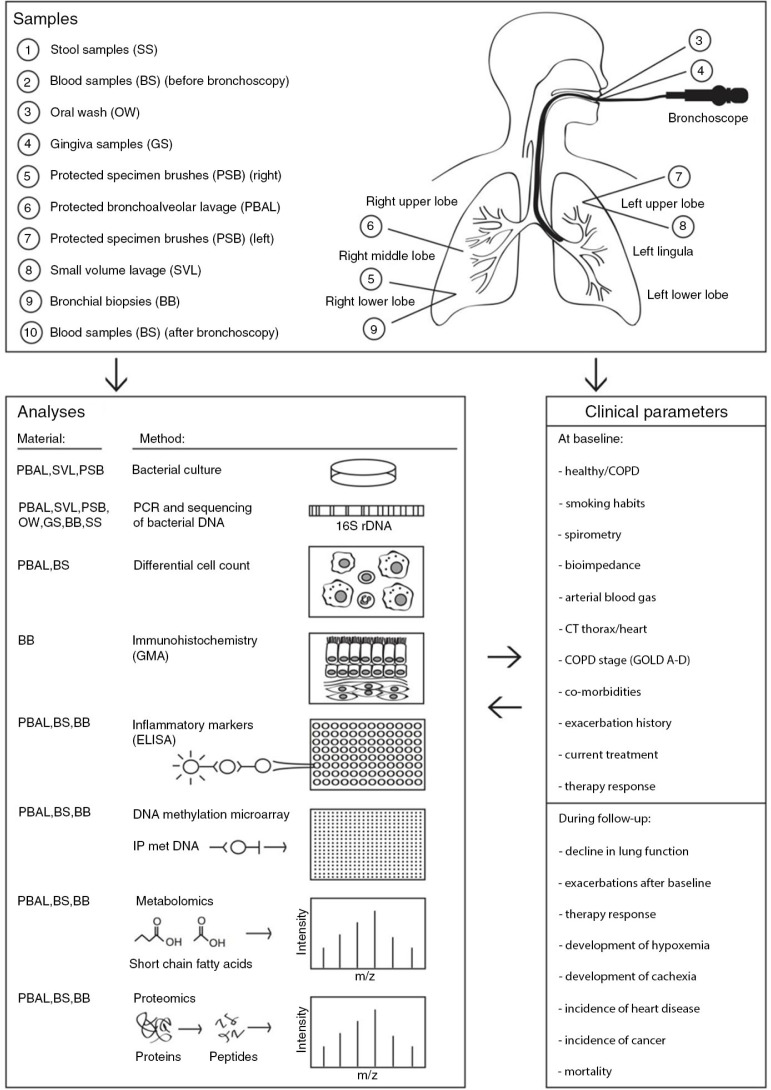
Overview of biological samples, analyses, and clinical parameters obtained from subjects included in the Bergen COPD microbiota study. Biological samples collected before, during, and after bronchoscopies, with order and location of sampling, are indicated in the figure. Stool samples (SS), blood samples (BS), oral wash (OW), and gingiva samples (GS) are collected before the bronchoscopy procedure. During the bronchoscopy, sampling is performed in the following order: three protected specimen brushes (PSB) from the right lower lobe (RLL), protected bronchoalveolar lavage (PBAL) from the right middle lobe (RML), three PSBs from the left upper lobe (LUL), small-volume lavage (SVL) from the LUL, and 4–6 bronchial biopsies (BB) from the RLL. Blood samples are also collected 1 h after the bronchoscopy procedure. The biological samples are analyzed by different methodologies; types of material used for the different analyses are indicated in the figure. Analyses include bacterial culture, PCR and sequencing of bacterial DNA (16S rDNA), differential cell count, glycol methyl acrylate (GMA) immunohistochemistry, analysis of inflammatory markers by ELISA (enzyme-linked immunosorbent assay), immunoprecipitation (IP) of methylated DNA followed by DNA methylation microarray, metabolomics, and proteomics. The results from the different analyses will be correlated to each other, in addition to clinical parameters of the patients obtained at the baseline visit and during follow-up. Examples clinical parameters are given in the figure. The bronchoscopy illustration is modified from http://www.patient.co.uk/health/bronchoscopy-leaflet.